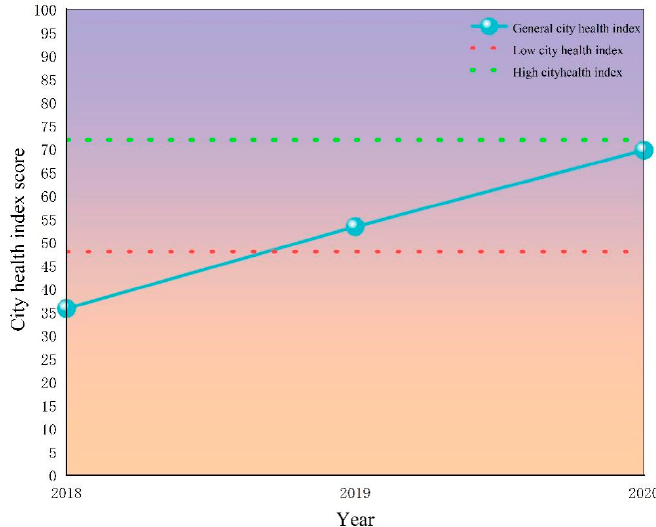
Figure 3. Changes in the total city health index in Xining City from 2018 to 2020.